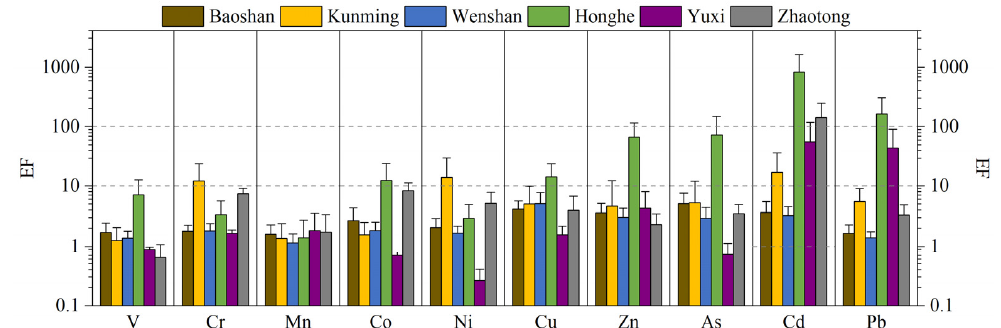
Figure 3. Enrichment factor of ten potentially toxic elements in PM 2.5 of soil fugitive